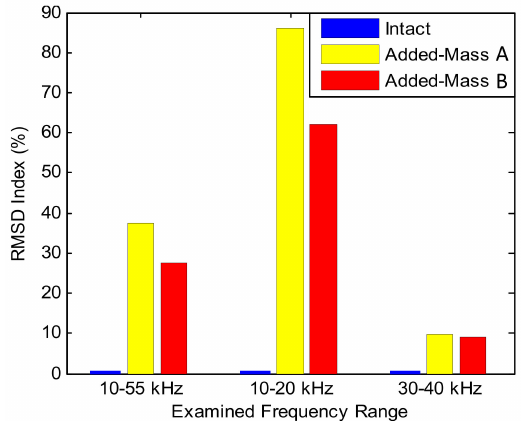
Figure 14. Experimental impedance features (RMSD indices) of PZT interface under damage cases in connection splice